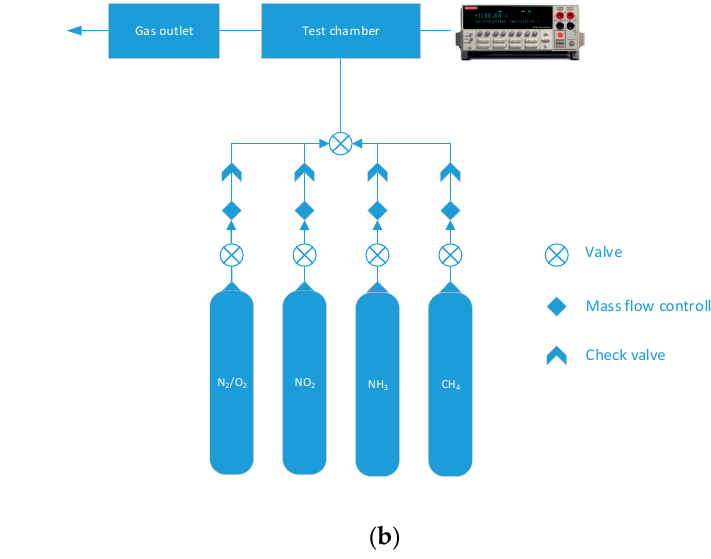
Figure 1. Photo of the active material (namely CNFs) on the copper electrodes on the textolite substrate ( a ); scheme of the installation for sensor testing ( b ).